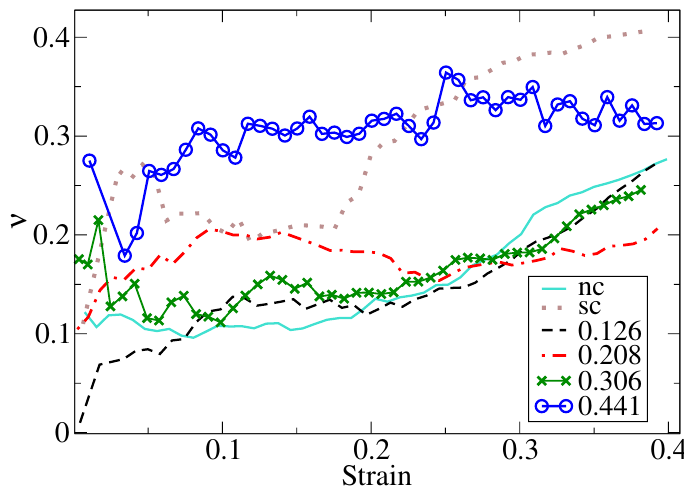
Figure 5. Effective Poisson’s ratio as a strain function for different φ